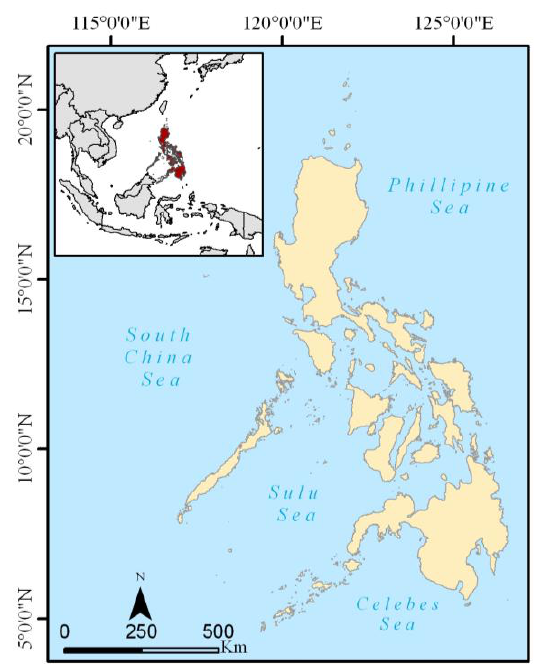
Figure 1. Location of study